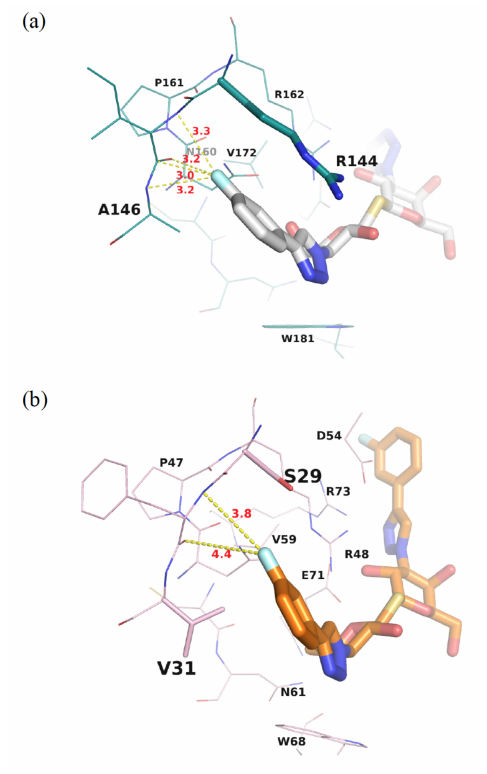
Figure 4. Close-up view of ( a ) GAL-3 and ( b ) GAL-1 subsite B in complex with TD139. The multiple fluorine bonds are shown as dotted yellow lines between the fluorine and the backbone peptide.